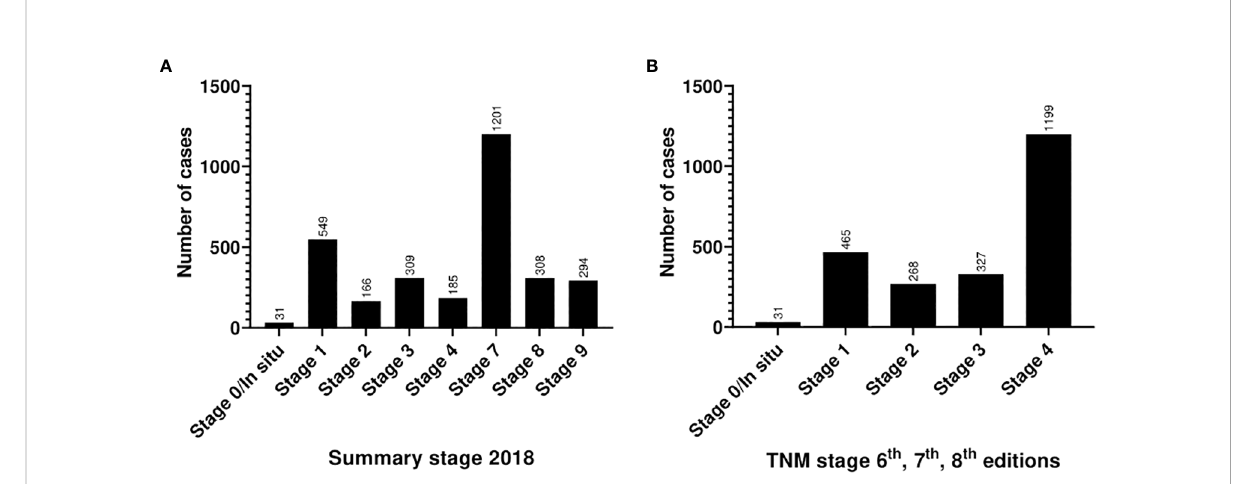
FIGURE 4 Stage-wise strati fi cation of patients according to (A) the 2018 version of Summary Stage and (B) the 6 th , 7 th and 8 th editions of the AJCC TNM staging